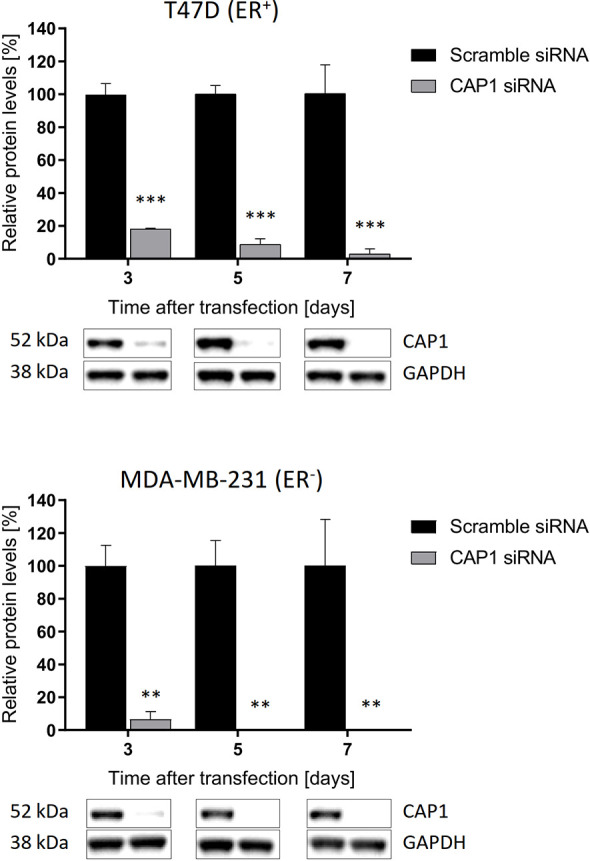
Sustained suppression of CAP1 protein levels following siRNA-mediated knockdown. Images and graphs show CAP1 levels 3, 5, and 7 days after siRNA transfection in ER-positive T47D cells and ER-negative MDA-MB-231 cells. Densitometry analysis of Western immunoblot data was performed and normalized against GAPDH housekeeping protein. Graphs show mean ± SEM from three independent experiments with statistical comparisons between groups by two-way ANOVA with Sidak’s post-hoc test. **P < 0.01; ***P < 0.001.